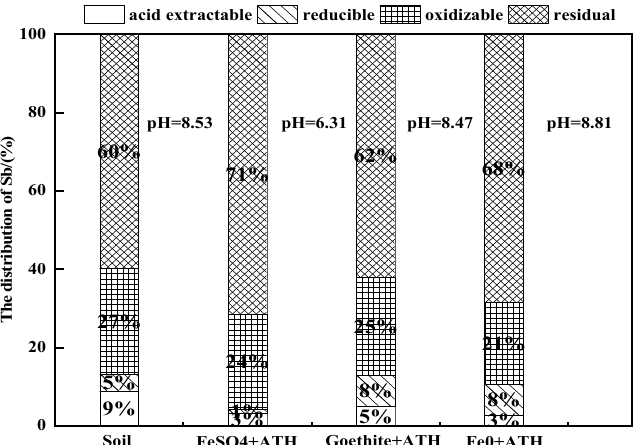
Figure 4. Sequential extraction of Sb in amended soil with Fe and Al mixed adsorbent.